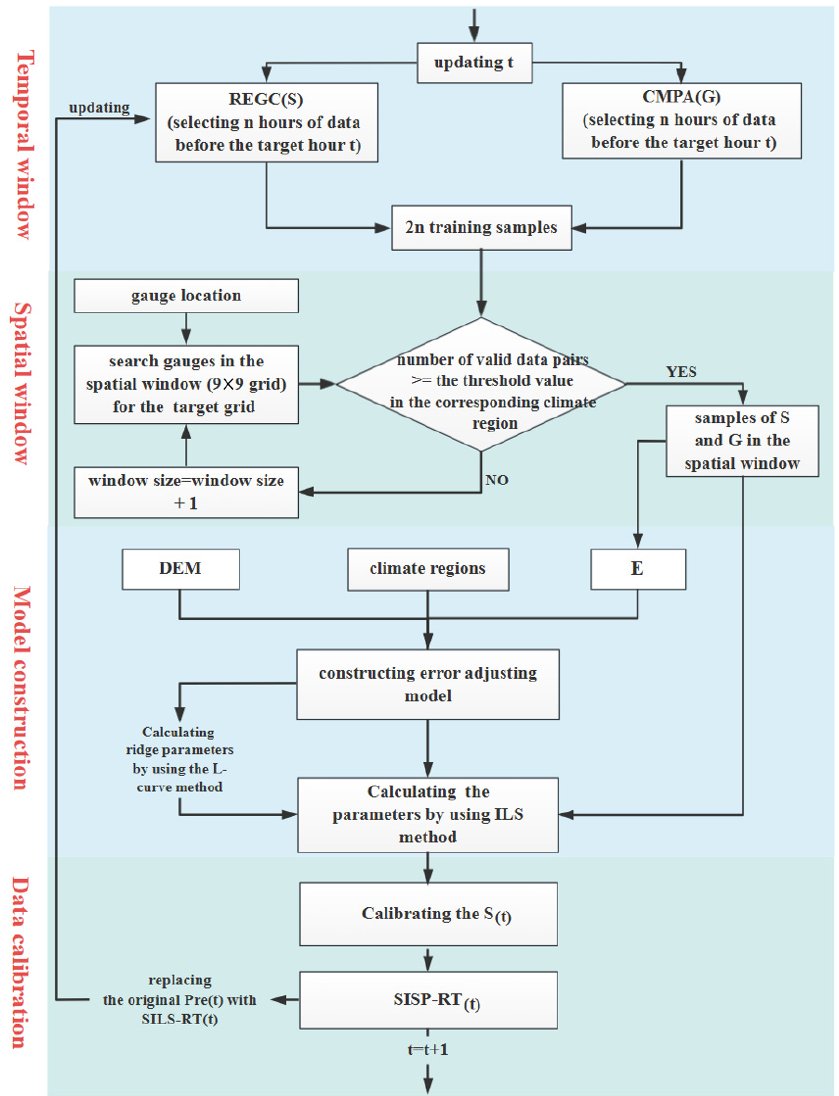
Figure 2. The fl owchart of adjusting hourly REGC. Figure 2. The flowchart of adjusting hourly REGC. (1) Self-adaptive selection of sample